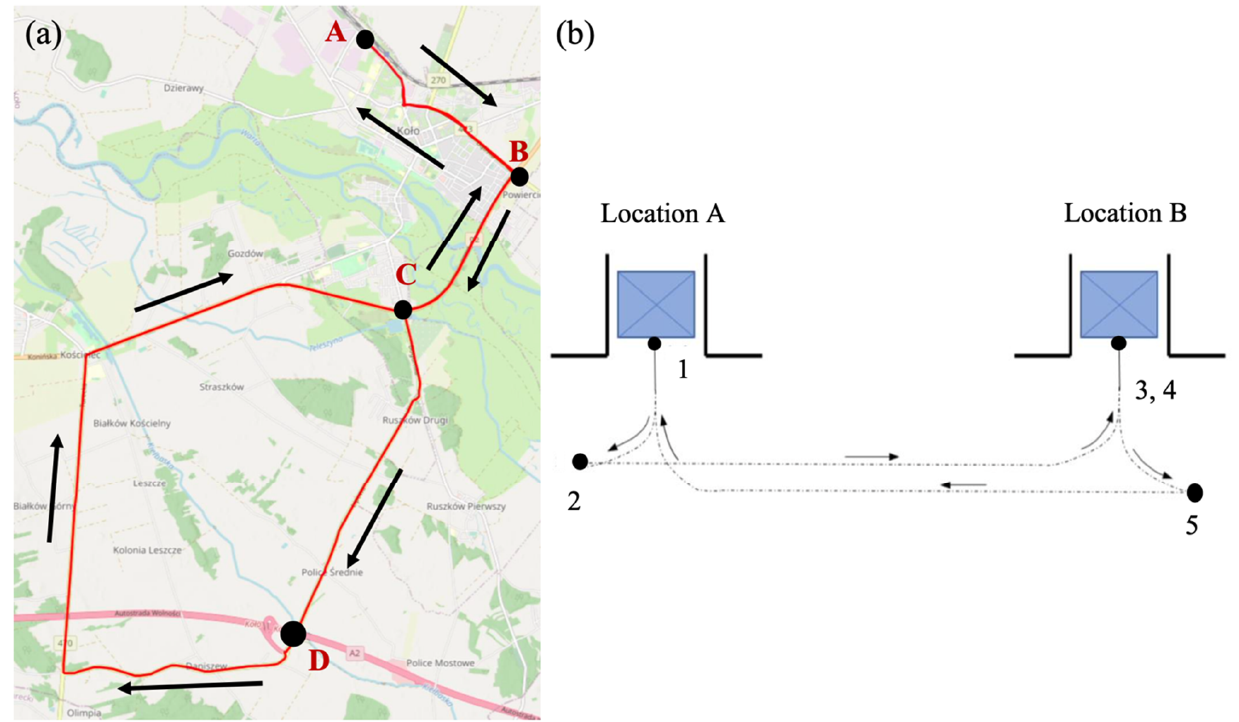
Figure 3. ( a ) test route of the tractor-trailer; ( b ) forklift research